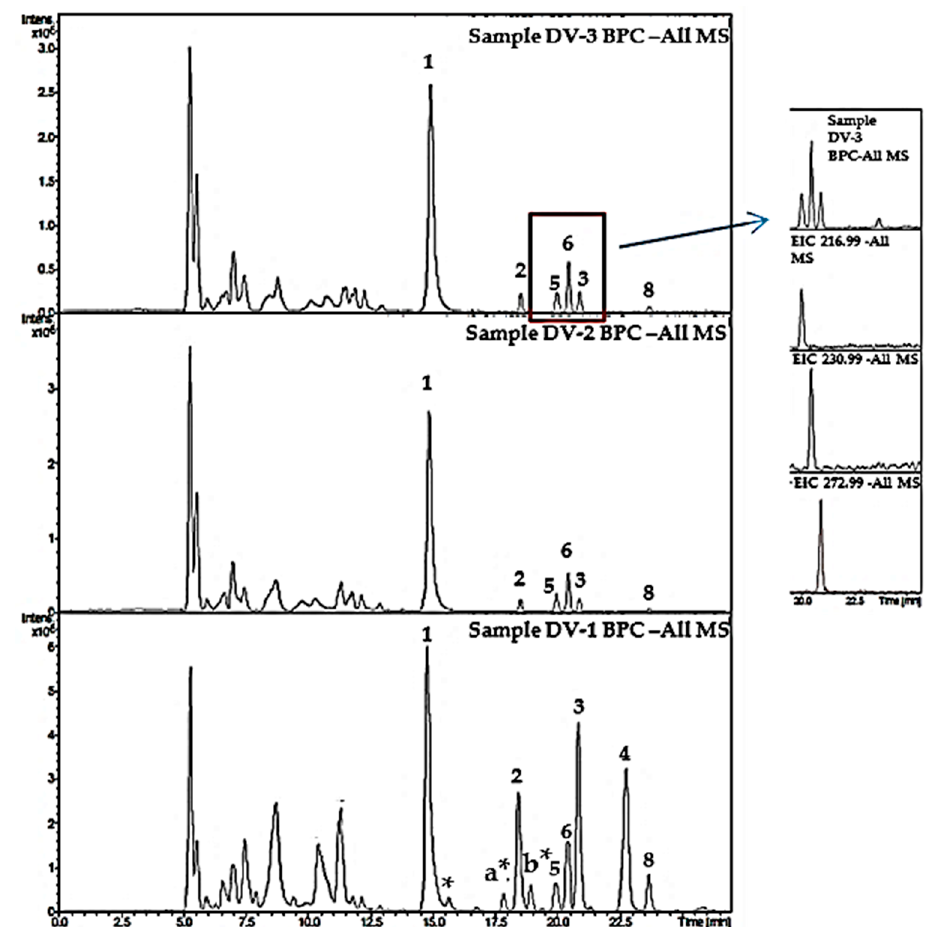
Figure 4. Base peak chromatograms of all extracts DV1-DV3 prepared from the marine green alga Dasycladus vermicularis . The red area is enlarged and shows the extracted ion chromatograms (EIC) for the sulfated phenolic acids SBA ( 5 ) and SPA ( 6 ). Tentatively identified minor coumarins are marked with a star (similar UV spectra) and with a * and b * (similar UV spectra and molecular weight).